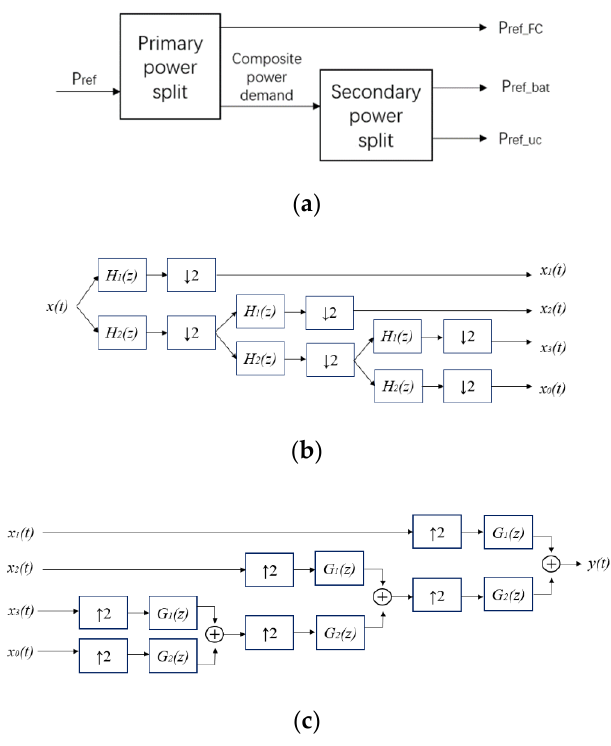
Figure 10. Energy split of a three-level wavelet transform: ( a ) demand power decomposition ( b ) Haar wavelet decomposition ( c ) Haar wavelet reconstruction.